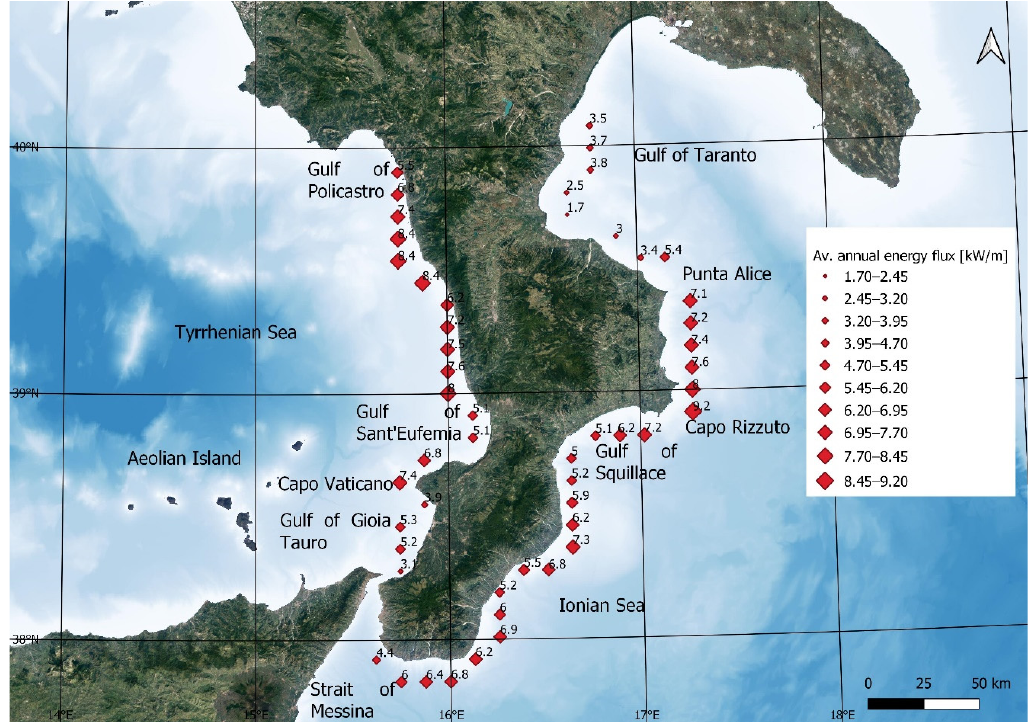
Figure 7. Average annual energy flux Φ t values. The range between the minimum and the maximum values has been divided into 10 intervals of the same width.